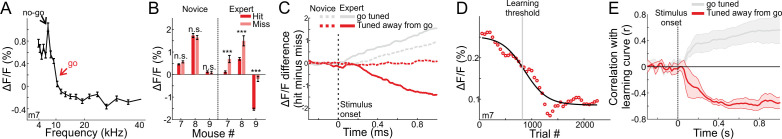
MGB responses tuned away from the go frequency are suppressed during learning.(A) Frequency tuning curve for an example mouse with peak tuning frequency away from the go sound. (B) Mean MGB calcium response during stimulus presentation per mouse in hit and miss trials. Left- novice mice, Right- expert mice. Error bars are s.e.m across trials. ***p<0.001. n.s. – not significant. Wilcoxon rank sum test. (C) Choice responses, averaged across the three mice that are tuned away from the go frequency, for the expert (solid line) and novice (dashed line) conditions. Gray traces are for the go-tuned mice, same as Figure 2D. (D) MGB response curve along learning in one mouse that is tuned away from the go frequency (compare to Figure 4A). (E) Correlation between MGB response curves and learning curves as a function of time, averaged across the three mice. Error bars are s.e.m across mice. Gray traces are for the go-tuned mice, same as Figure 4C.